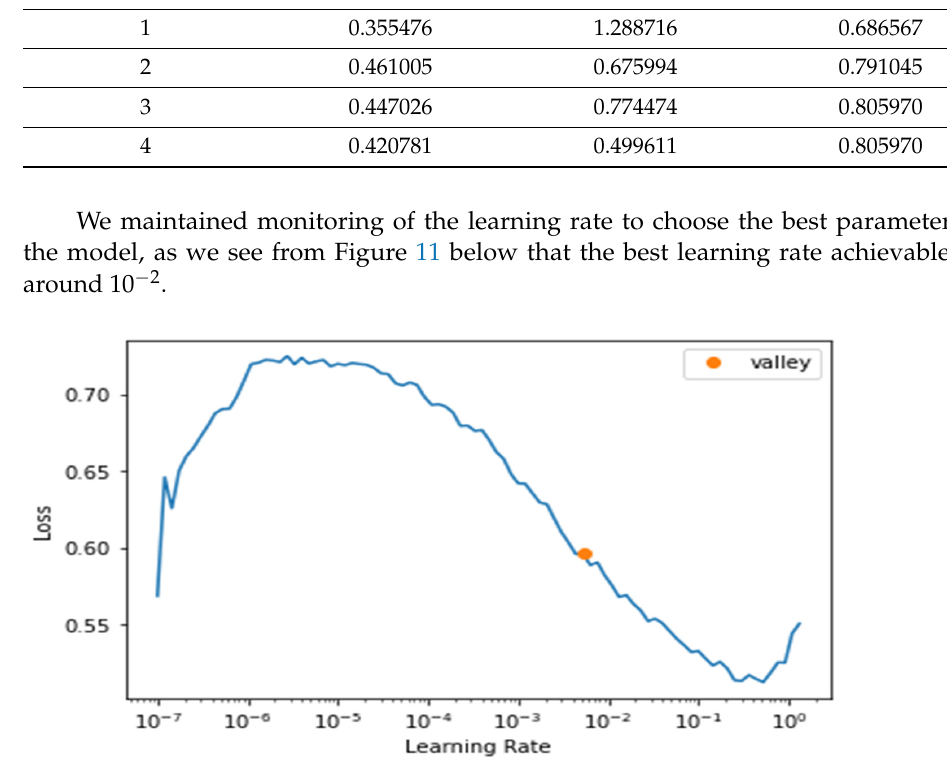
Table 3. Performance results of the fastai LSTM model.